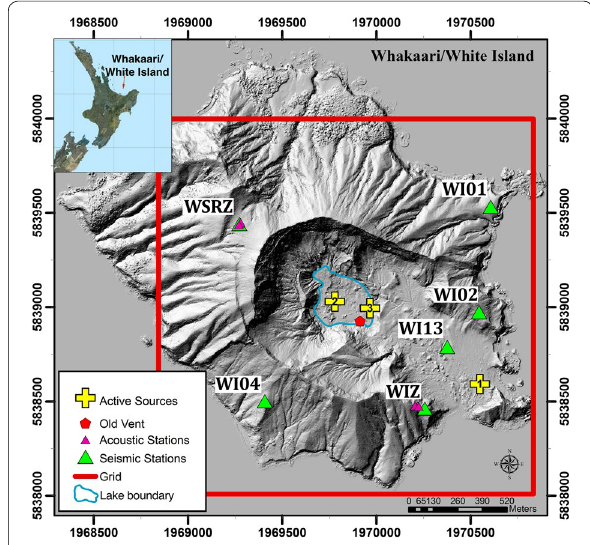
Fig. 1 Map of Whakaari Island, New Zealand, depicting the locations of seismometers (green triangles), acoustic sensors (magenta triangles), and active source drops (yellow